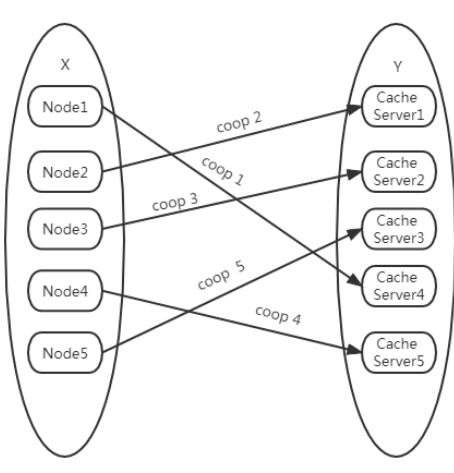
Figure 5. Maximum weight matching in bipartite